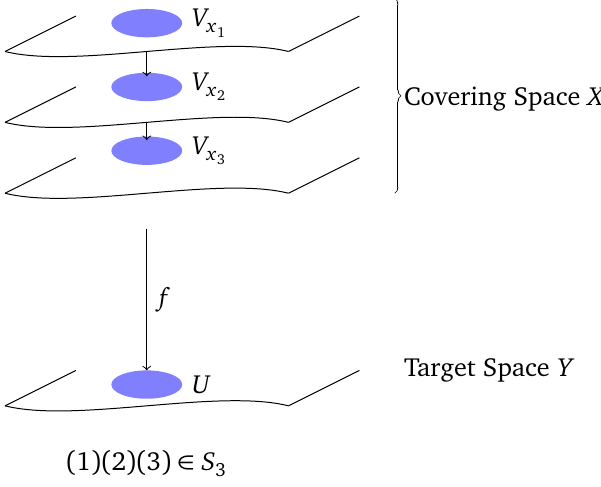
Figure 1: A 3-fold covering space X over a target space Y .